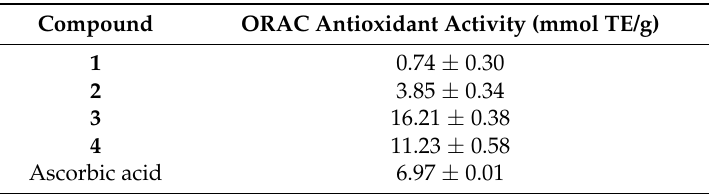
Table 2. Antioxidant activity of compounds 1 – 4 in ORAC